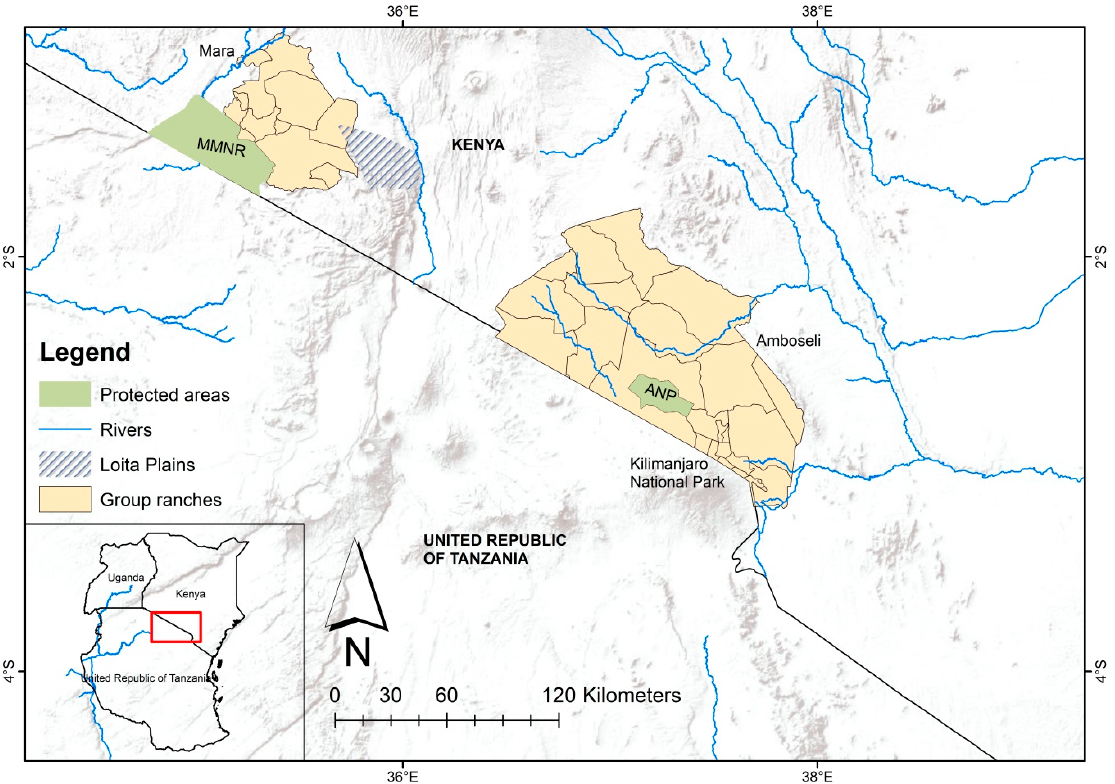
Figure 1. Location of the study areas and the surrounding ecosystems in southern Kenya. Protected areas labelled ANP and MMNR are Amboseli National Park and Maasai Mara National Reserve, respectively. Base Layer Source: Esri.